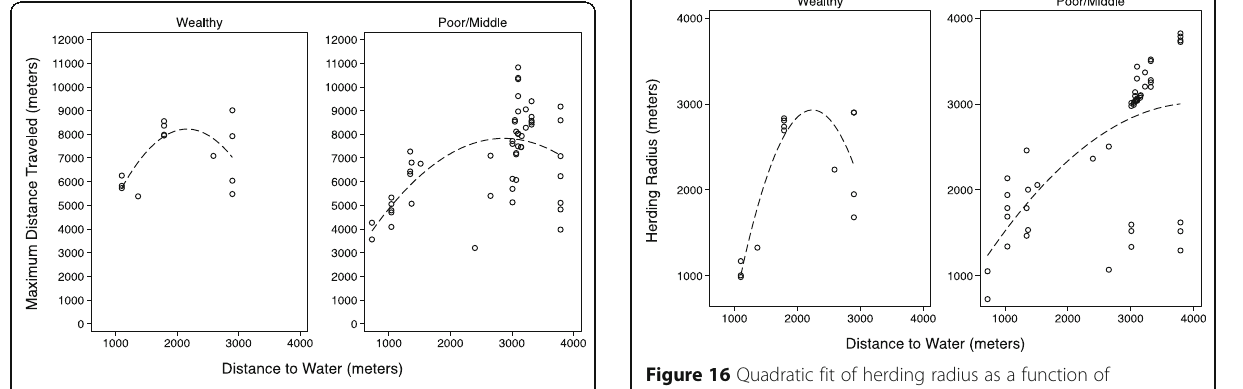
Figure 15 Quadratic fit of maximum distance travelled as a function of maximal distance to water by wealth rank. Wealthy families travel shorter distances to reach water, meaning they spend less time trekking to water and more time grazing